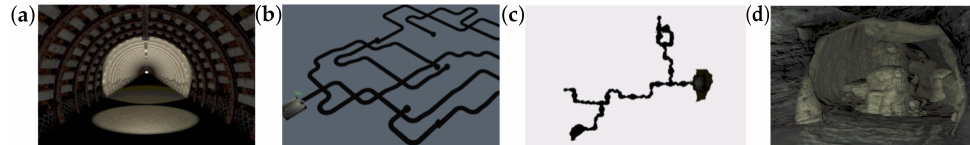
Figure 1. Screenshots of different virtual environments, each spanning hundreds of meters in length and width. ( a ) A simple, straight tunnel environment of radius 1.75 m and length 600 m. ( b ) Overview of a larger, more complex tunnel environment with an average radius of 1.75 m and spanning approximately 200 m width × 300 m length. ( c ) Top-down view of a cave environment spanning approximately 600 m length × 425 m width, with an average cave radius greater than 5 m. ( d ) Entrance to a cave world environment, spanning approximately 10 m width × 15 m height × 20 m